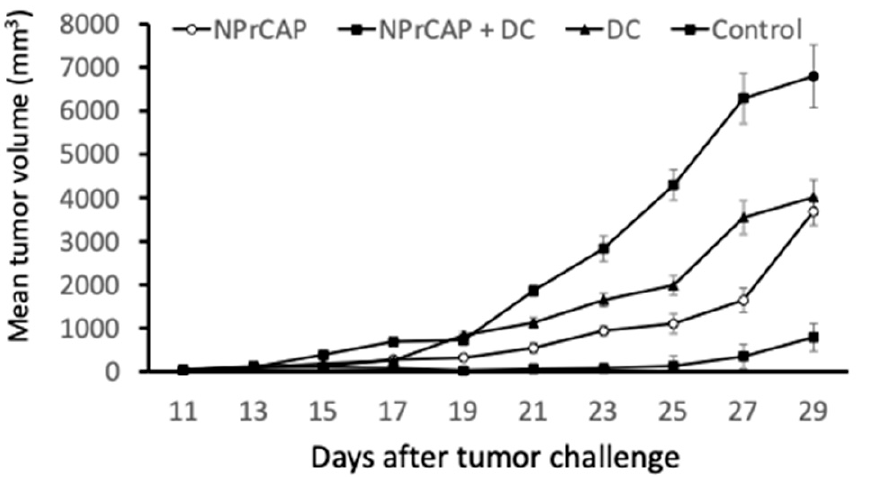
Figure 3. N -Pr-4- S -CAP inhibits B16F1 melanoma growth and combination therapy with an intratu- moral injection of BMDCs augments the anti-tumor activity of N -Pr-4- S -CAP anti-tumor. Mice were transplanted with B16F1 cells and treated with N -Pr-4- S -CAP, BMDCs and N -Pr-4- S -CAP in com- bination with BMDCs. Mice bearing B16F1 melanomas were treated with 24.4 µ mol N -Pr-4- S -CAP, BMDCs (1 × 10 5 ) or N -Pr-4- S -CAP and BMDCs by intratumoral injections on days 11 and 13. Tumor diameters were measured every other day.